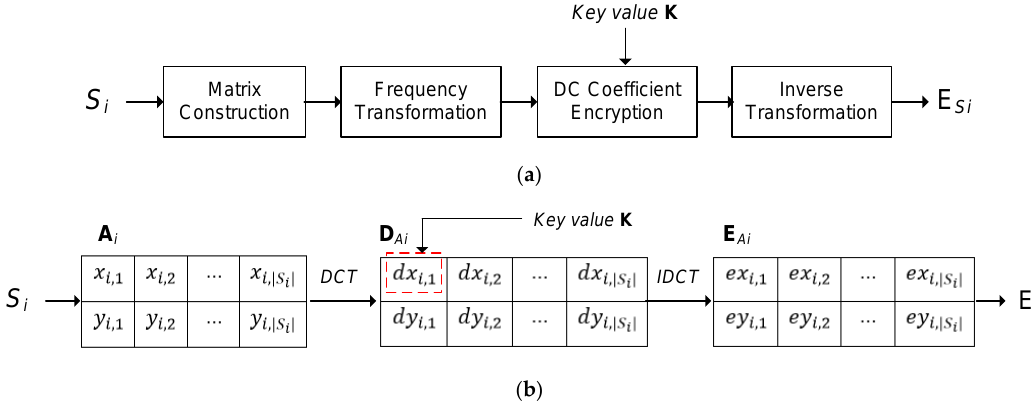
Figure 6. ( a ) Overview encryption method in the frequency domain, ( b ) The encryption process of 2D slices in Discrete Cosine Transform (DCT) domain.